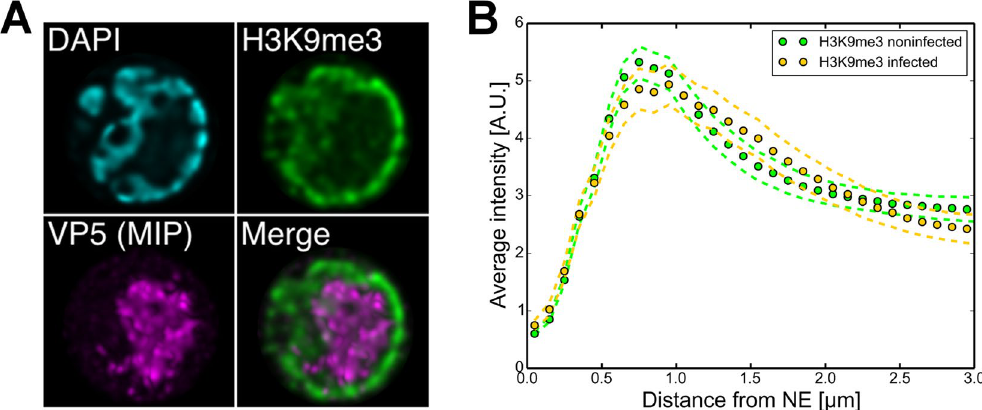
Figure 2. Redistribution of heterochromatin marker. ( A ) Confocal microscopy images of an infected cell with an enlarged VRC, stained with antibodies for VP5 (magenta), heterochromatin marker H3K9me3 (green) and DAPI (cyan) at 24 h p.i. See also Supplementary Figure S3. ( B ) Plot of the intensity of H3K9me3 in infected (yellow) and non-infected (green) cells as a function of the distance from the NE. Dotted error lines represent the mean ±